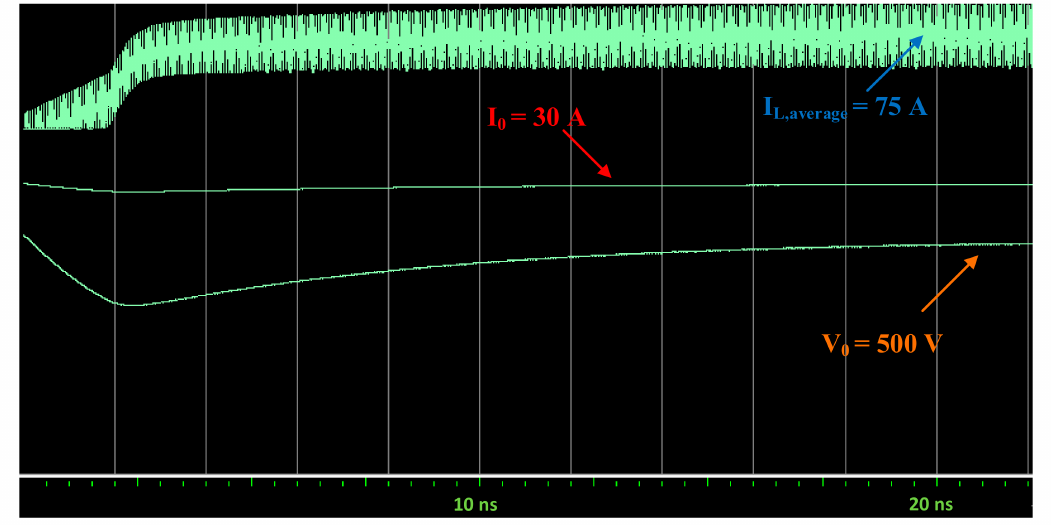
Figure 10. Simulation results obtained in ModelSim with the implemented circuit and the test